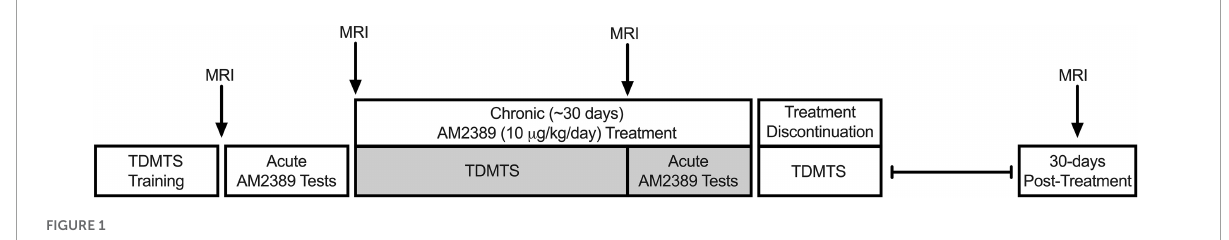
FIGURE1 Experimental